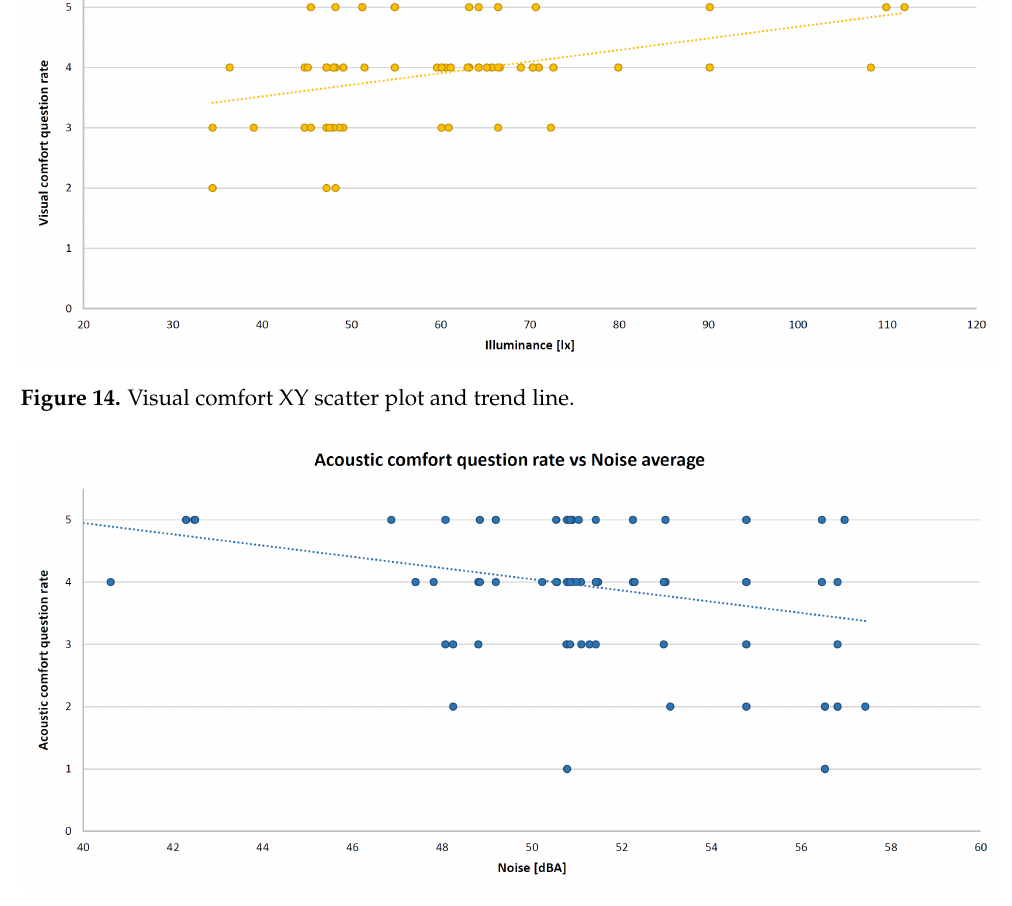
Figure 15. Acoustic comfort XY scatter plot and trend